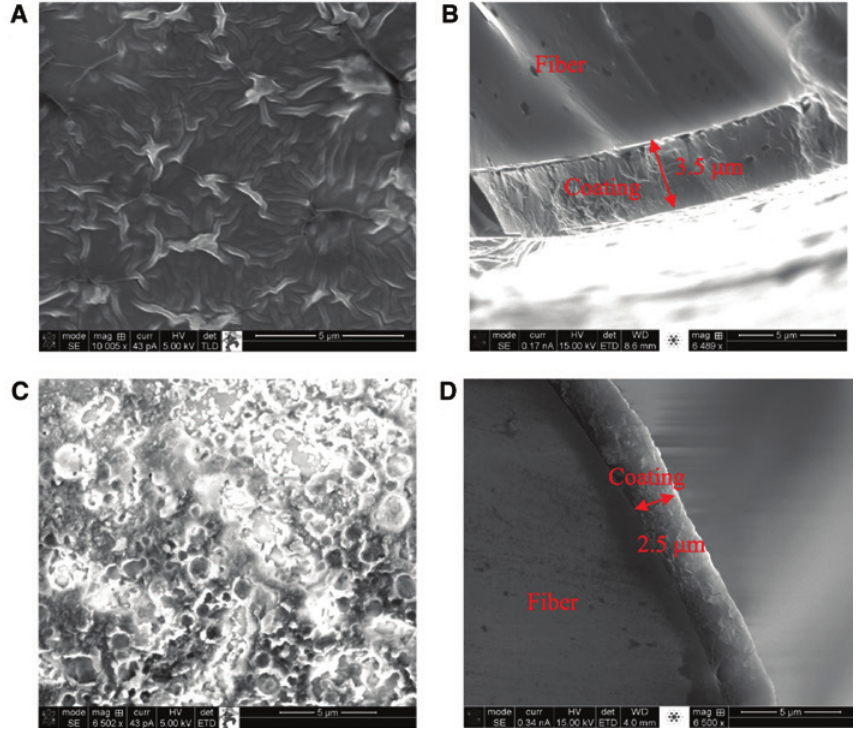
Figure 4: Surface (A) and cross-section (B) SEM images of the deposited coating on the fiber with iron and silica nanoparticles dispersed into polyurethane, and surface (C) and cross-section (D) SEM images of the same sample after the heating process of the coating. Figures adapted with permission from Ref. [39]. Copyright (2013) IOP